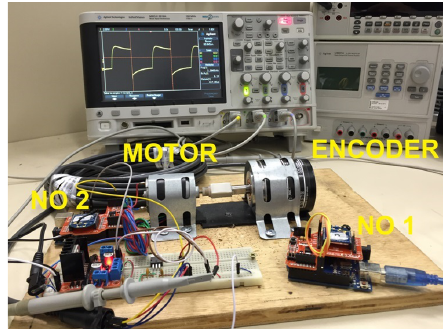
Figure 3. Test plant schematic.